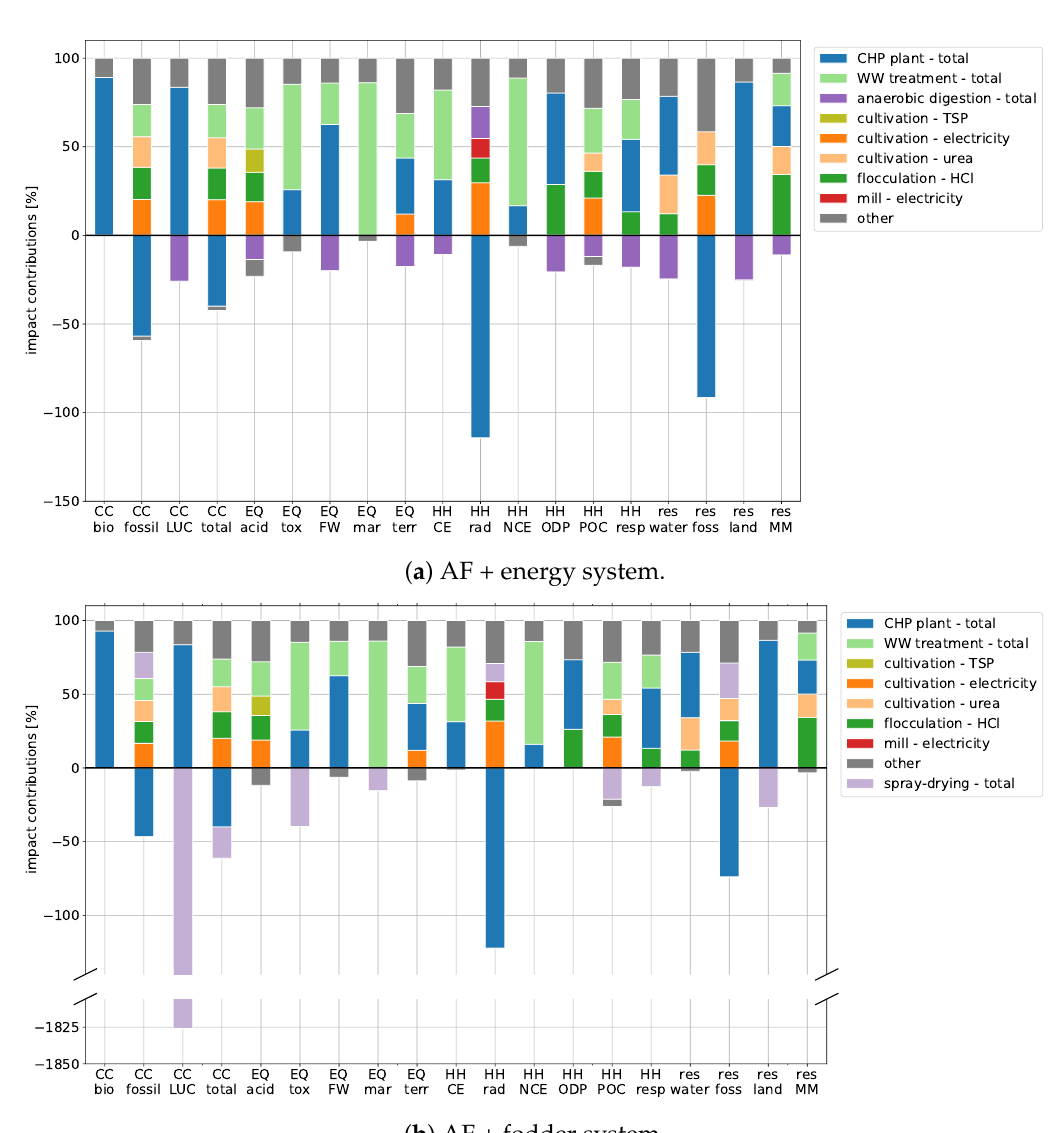
Figure 3. Break-down of environmental impacts: ( a ) AF + energy. ( b ) AF + fodder. Note that the bars are normalized by the sum of positive (i.e., damaging) impacts. Abbreviations: CC—climate change; EQ—ecosystem quality; HH—human health; res—resource depletion; bio—biogenic; LUC—land use and land use change; acid—freshwater and terrestrial acidification; tox—freshwater ecotoxicity; FW—freshwater eutrophication; mar—marine eutrophication; terr—terrestrial eutrophication; CE—carcinogenic effects; rad—ionizing radiation; NCE—non-carcinogenic effects; ODP—ozone depletion potential; POC—photochemical ozone creation; resp—respiratory effects; water—water dissipation; foss—fossil; land—land use; MM—minerals and